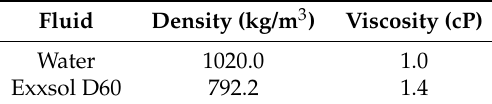
Table 1. Test fluid properties at 20 ◦